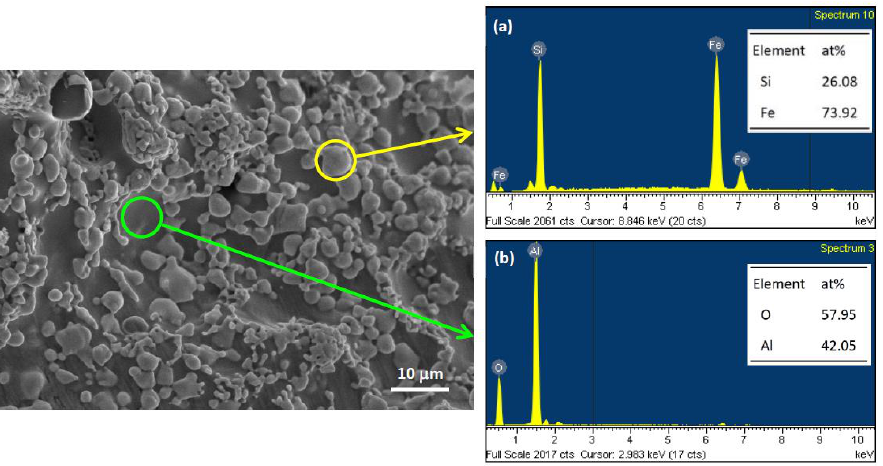
Figure 7. SEM image and EDS spectra associated with ( a ) Fe 3 Si and ( b ) Al 2 O 3 of SHS-derived product from Reaction (1) with x = 0.75.